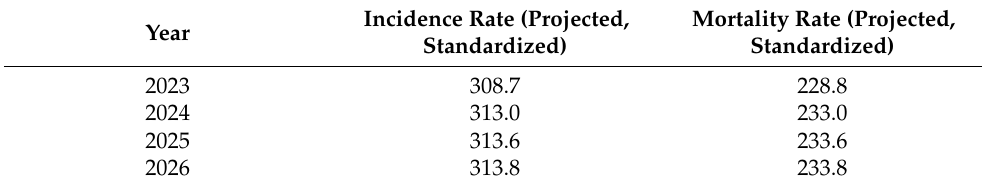
Table 3. Forecasted values for cancer incidence and cancer mortality rates. Incidence Rate (Projected, Mortality Rate Year Standardized)